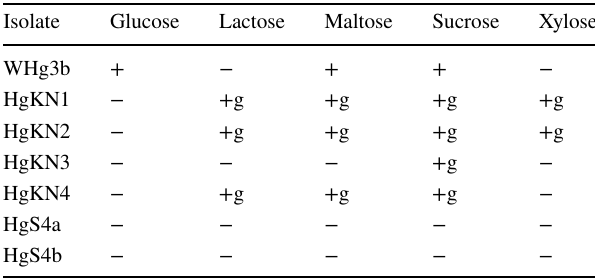
Table 3 Sugar fermentation by mercury-resistant isolates